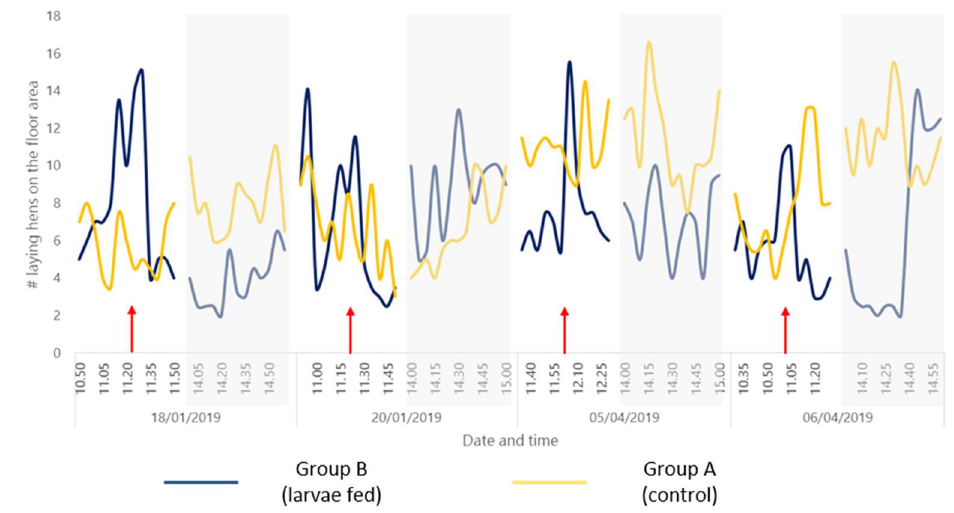
Figure 2. Number of hens observed at the floor area of pen in Group A (control) and Group B (larvae fed) at the initiation (18 / 01 / 2019 and 20 / 01 / 2019) and termination (05 / 04 / 2019 and 06 / 04 / 2019). Observations were performed in morning (after loading of larvae in dispenser, approx. 11.00 a.m. to 12.00 p.m.) and afternoon (2.00 p.m. to 3.00 p.m.). Red arrows indicate time of larvae supply.